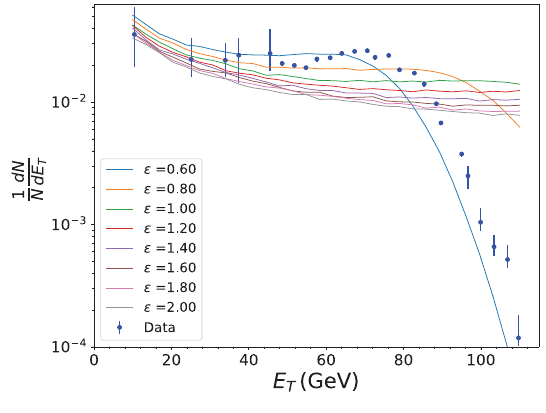
Figure 5. Equation 1 fitted with various values of (cid:4) to the data in figure